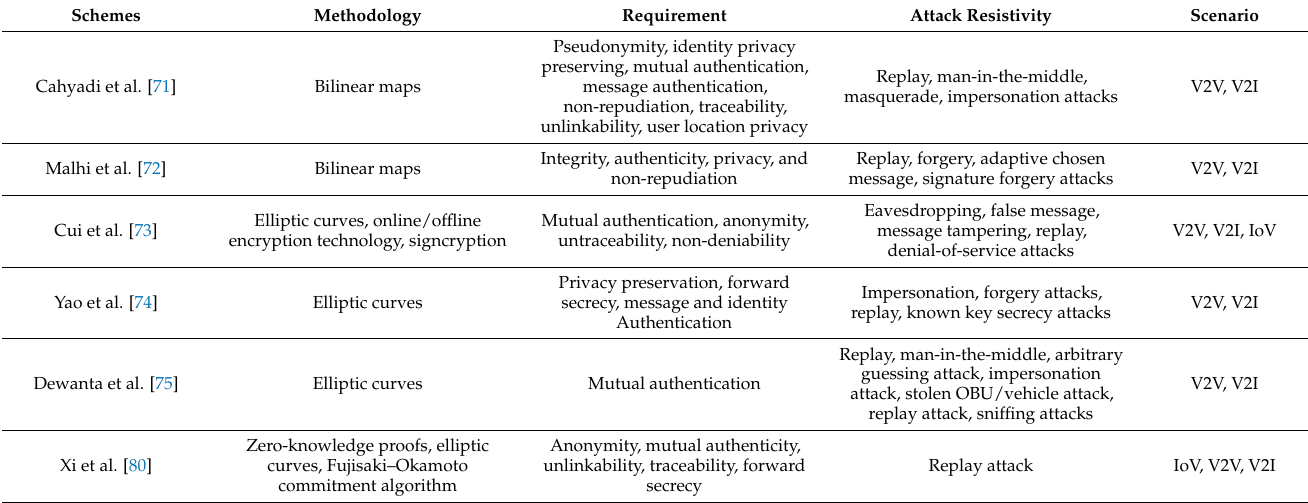
Table 5. Classification of mutual-authentication-based certificate-less aggregate signature schemes.